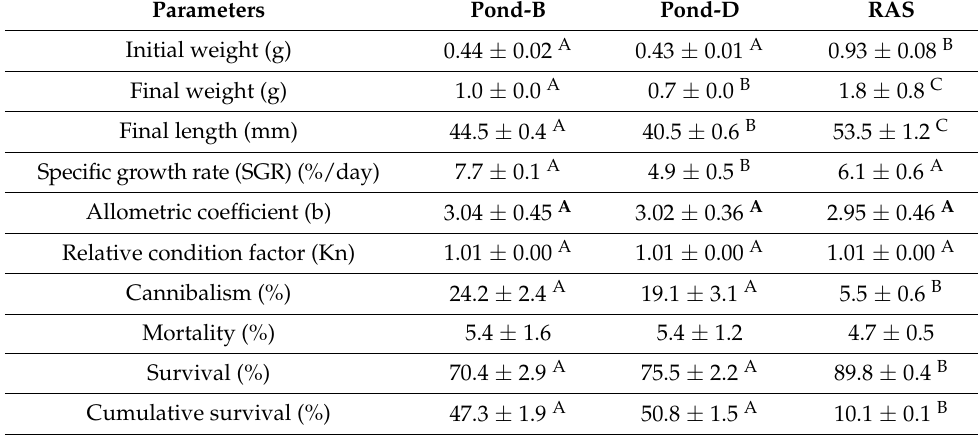
Table 2. T Survival and morphometry of pond and RAS produced pike-perch Sander lucioperca juveniles at the end of the habituation period, on the 52 DPH (mean ± S. D., n = 3 tanks); results of post-hoc tests are provided as